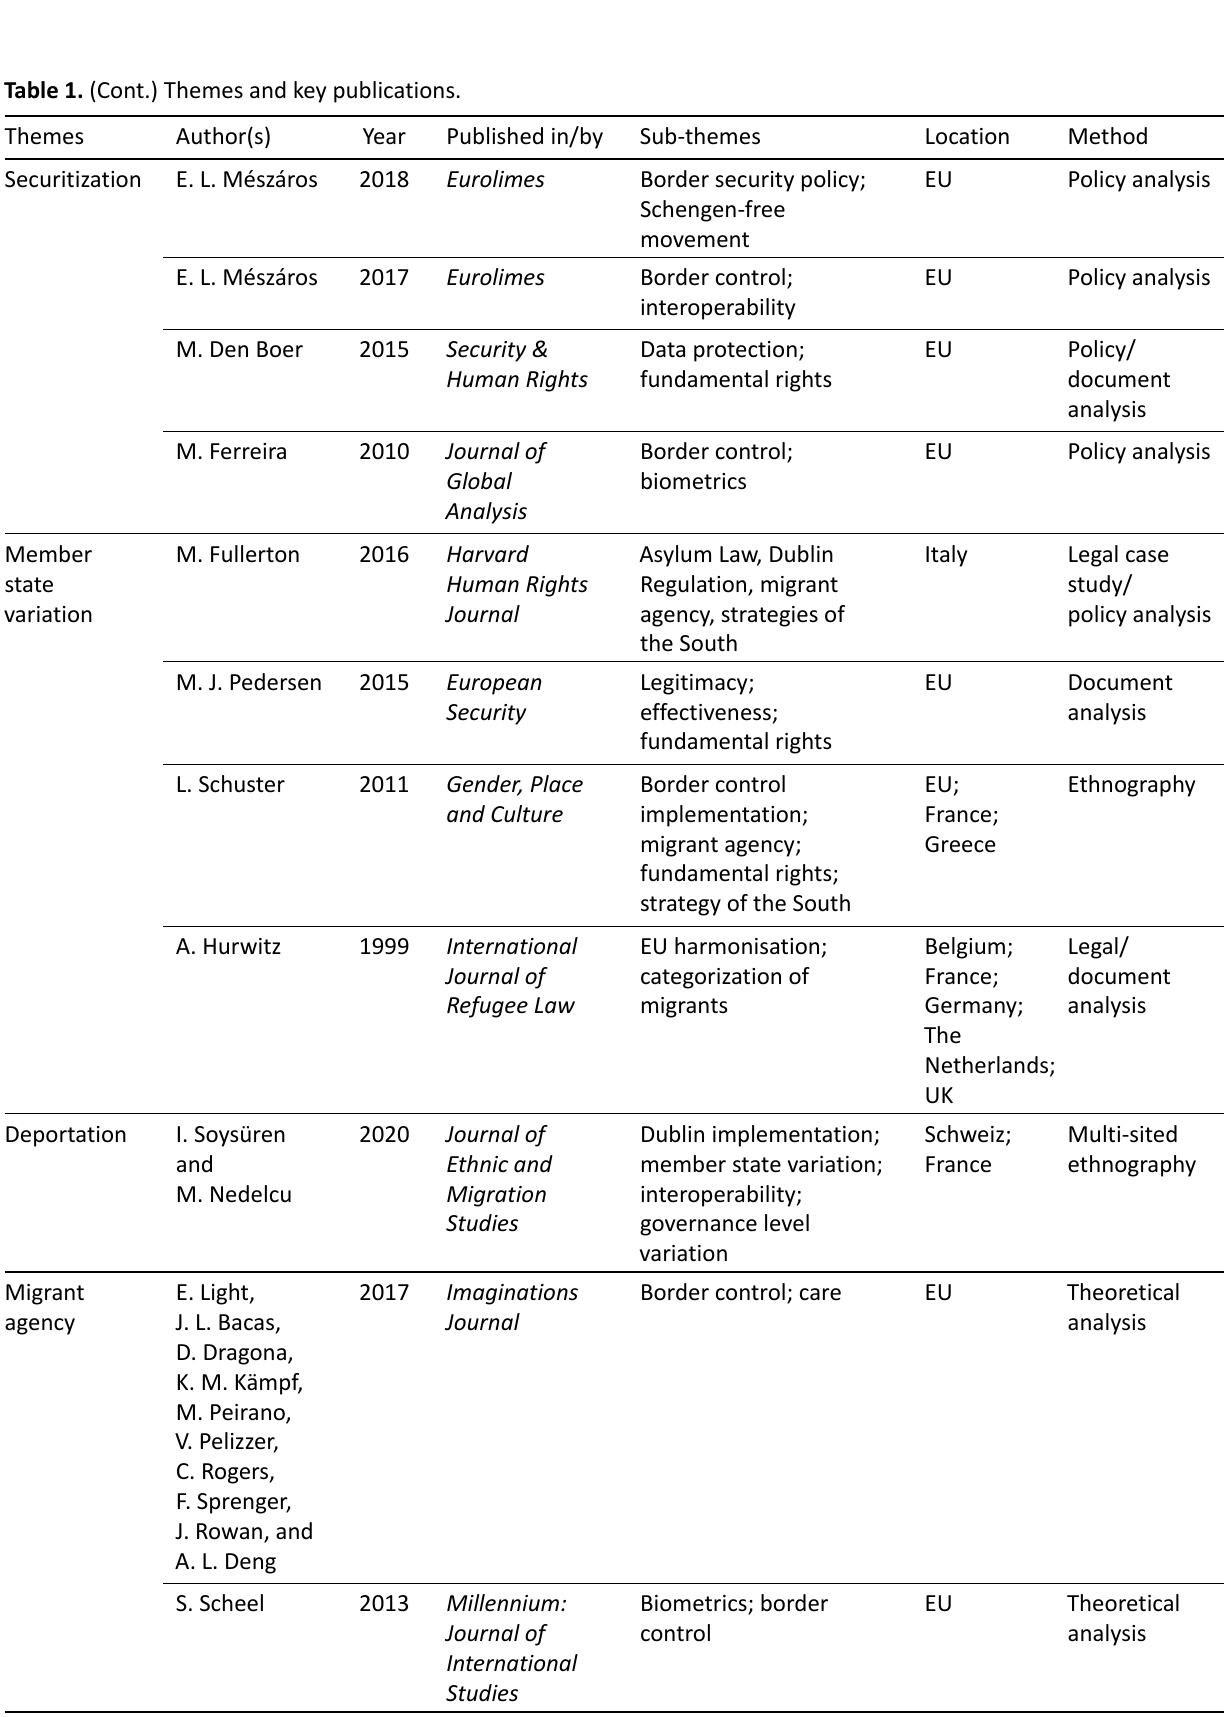
Table 1. (Cont.) Themes and key